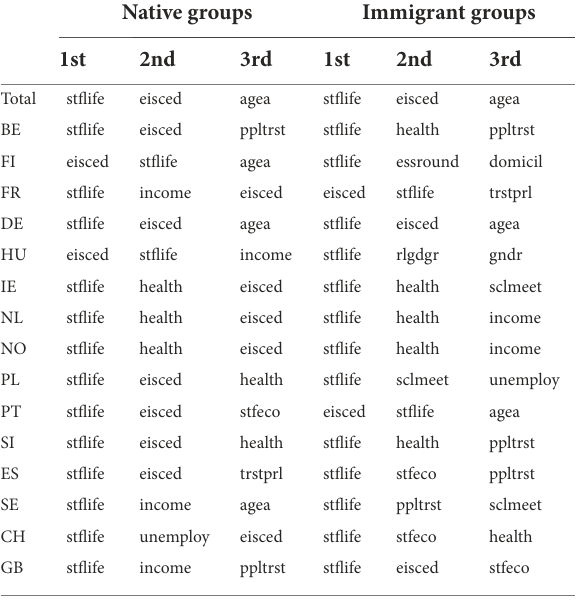
TABLE 5 Variable importance from native groups’ ANN models. Native groups